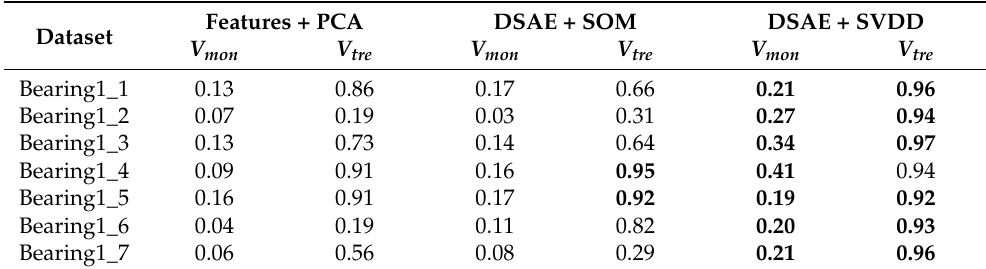
Table 4. Evaluation results of HI curves constructed by different